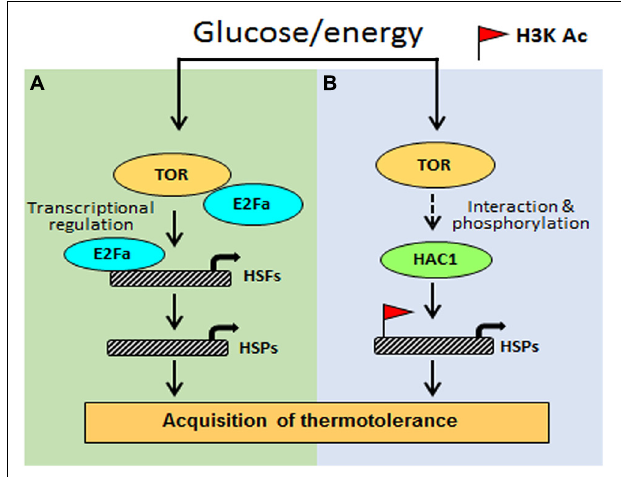
FIGURE 9 | The proposed model shows how Glc-TOR signalling regulates thermotolerance. (A) TOR-regulated E2Fa transcription factor recruited at the promoters of HSFA1 and HSFA2 genes to control their expression, which, in turn, regulate HS gene expression. (B) Glc through TOR promotes recruitment of histone H3 acetylation marks at the promoters of HS genes to induce their transcription, leading to thermotolerance. This Glc-TOR-mediated histone acetylation is facilitated through